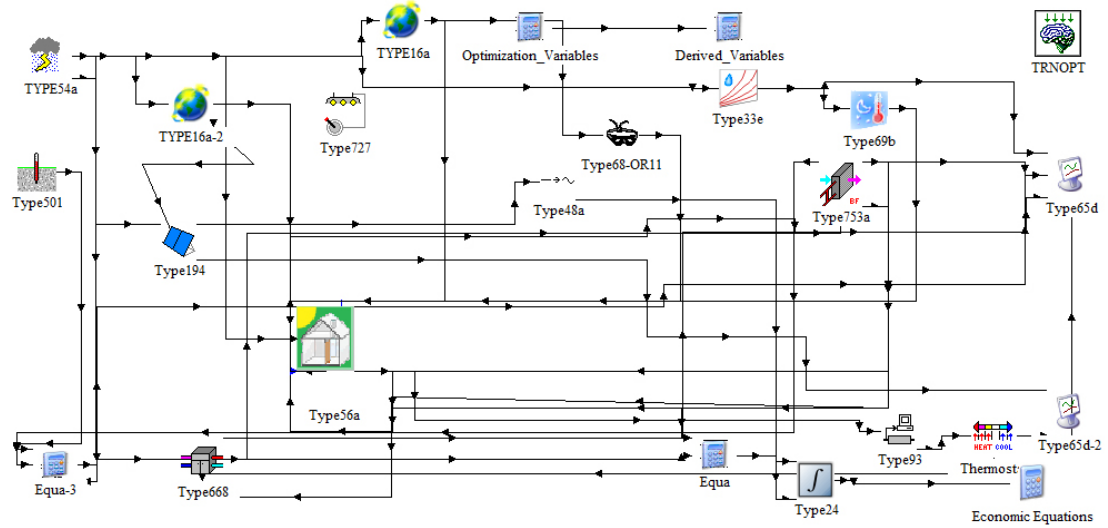
Figure 2. TRNSYS project file components (Types) of the simulated system.